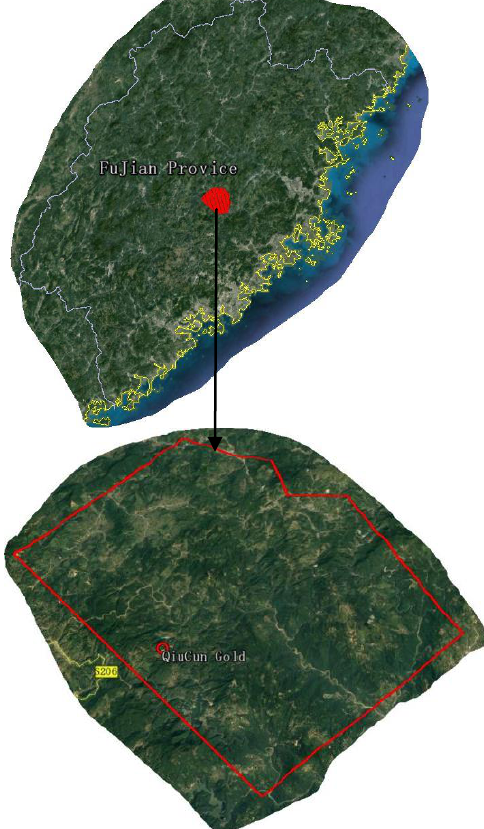
Figure 1. Location map of study